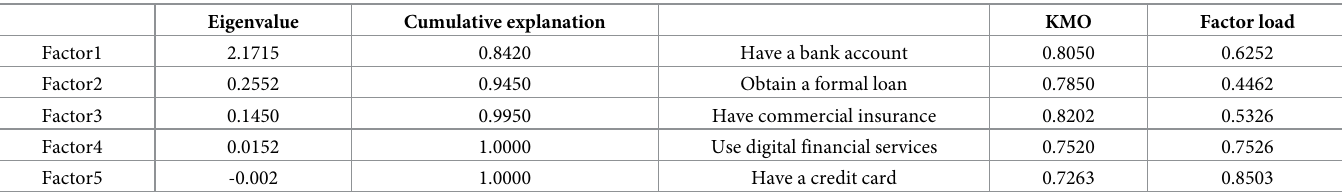
Table 2. Results of factor analysis.